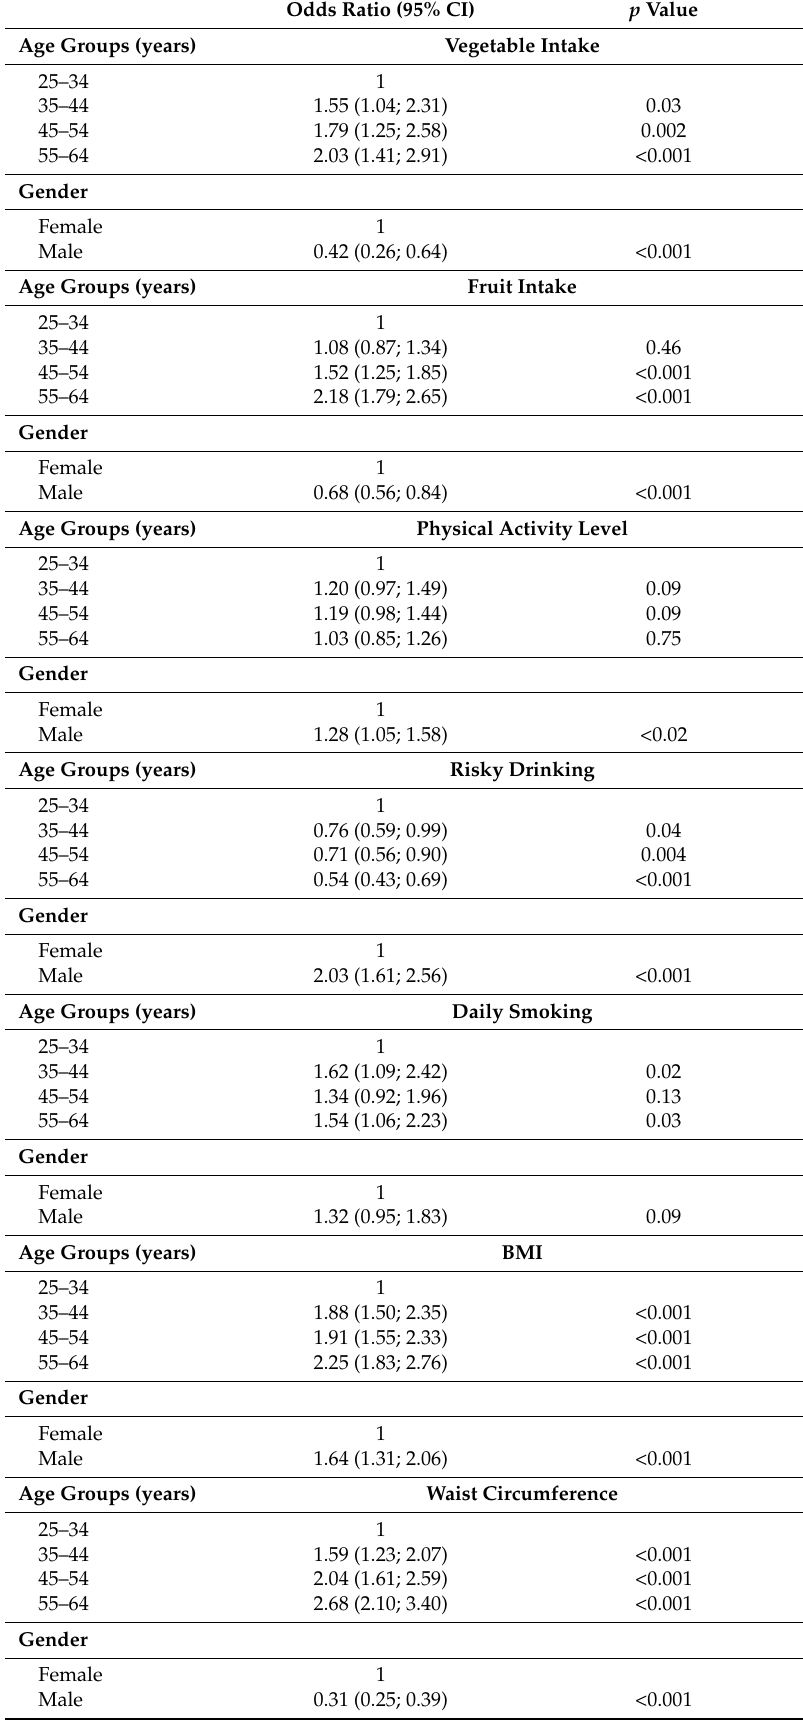
Table 2. Associations between health behaviors, age and